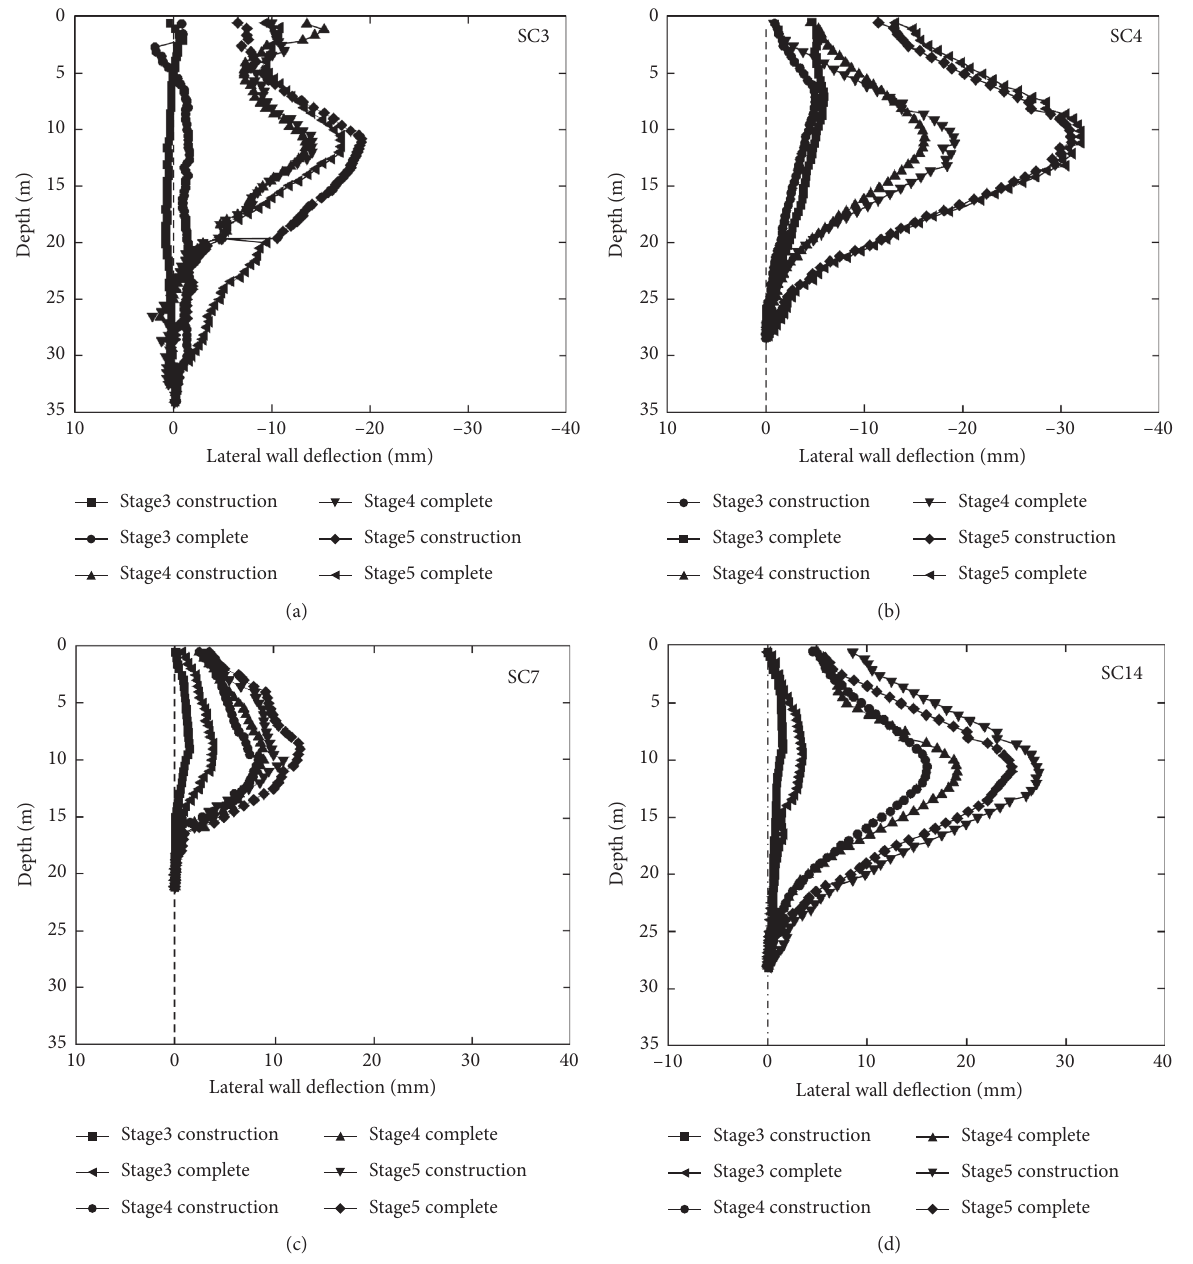
Figure 5: Summary of the effective lateral wall deflections at (a) SC3; (b) SC4; (c) SC7; and (d)